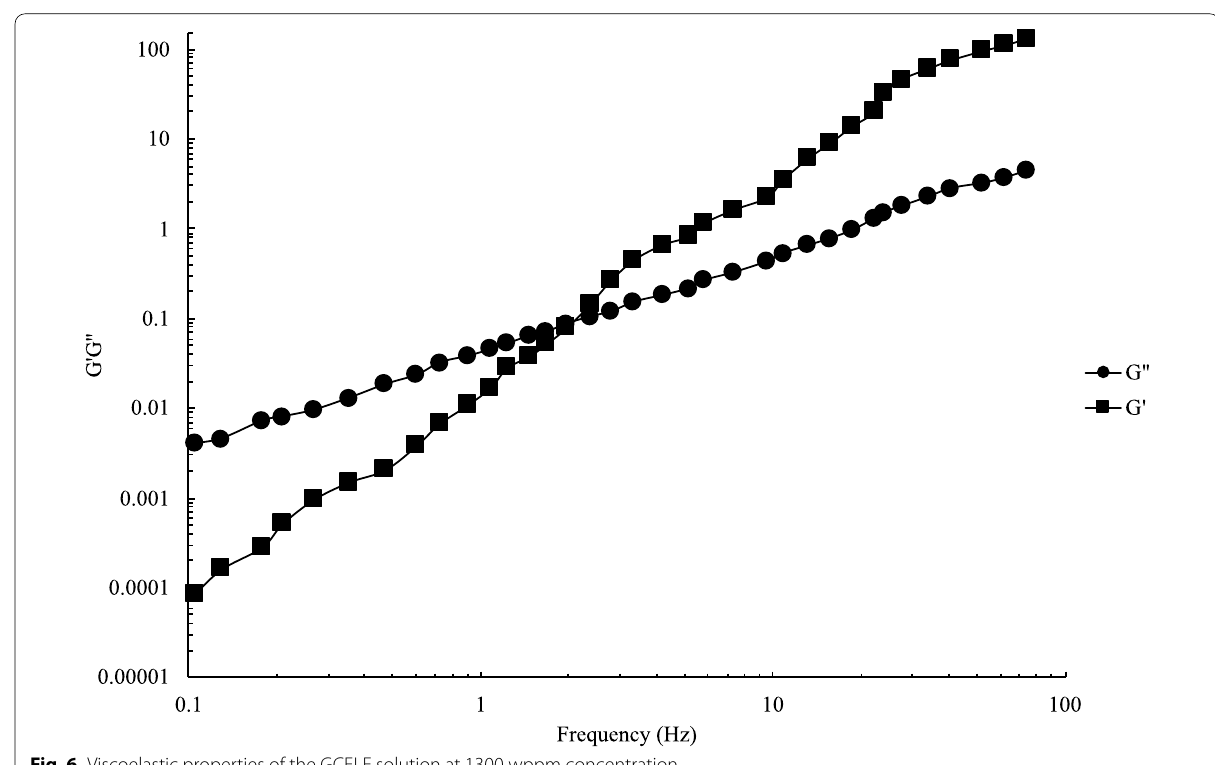
Fig. 6 Viscoelastic properties of the GCELE solution at 1300 wppm